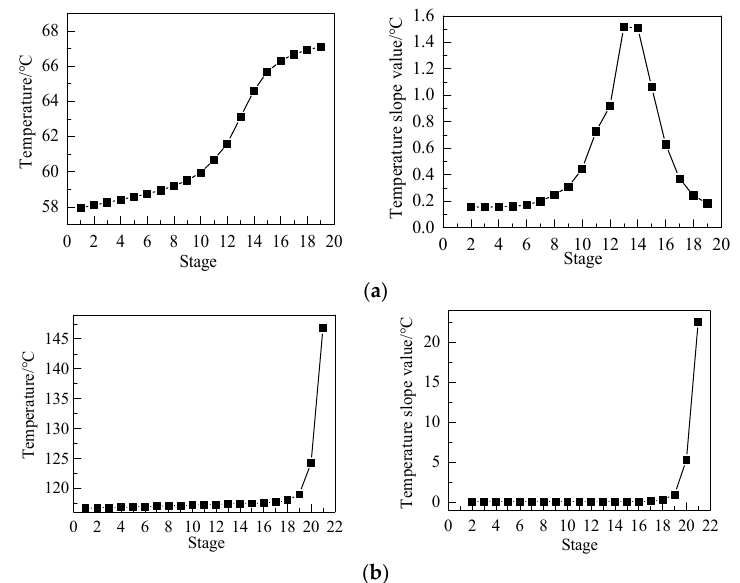
Figure 8. Temperature distribution and their slope distribution: ( a ) high pressure column (HPC), ( b ) low pressure column